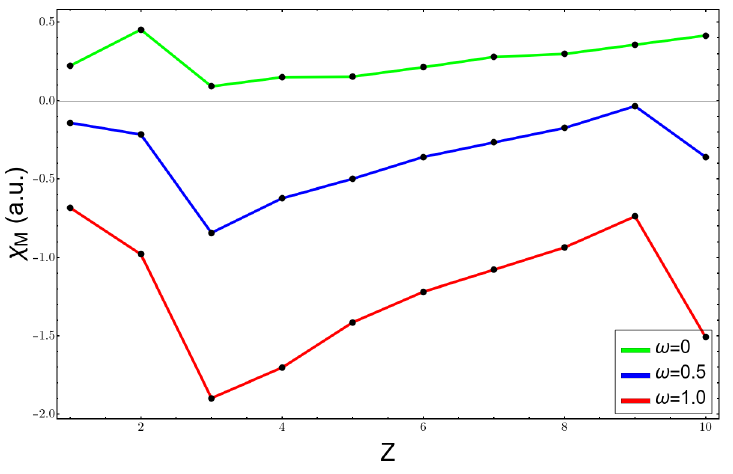
Figure 4. Mulliken’s electronegativity at different confinement values for the atoms from H to